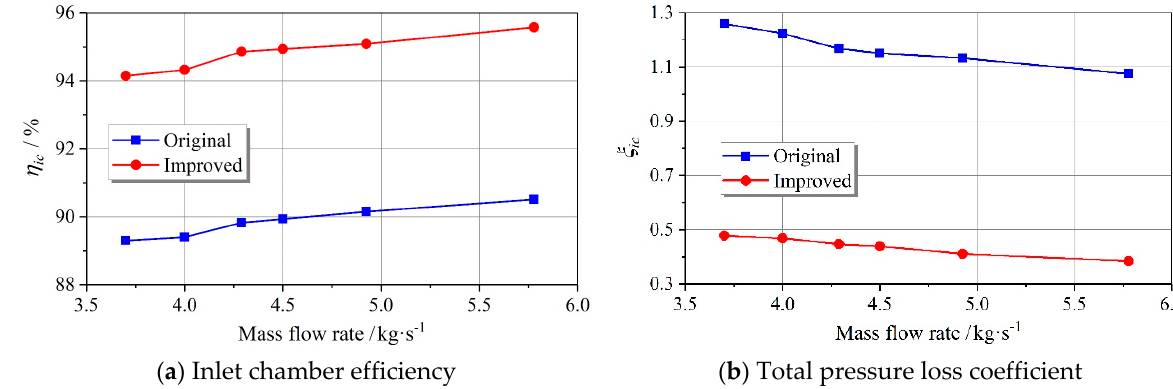
Figure 13. Performance comparison of the radial inlet chambers under different conditions.